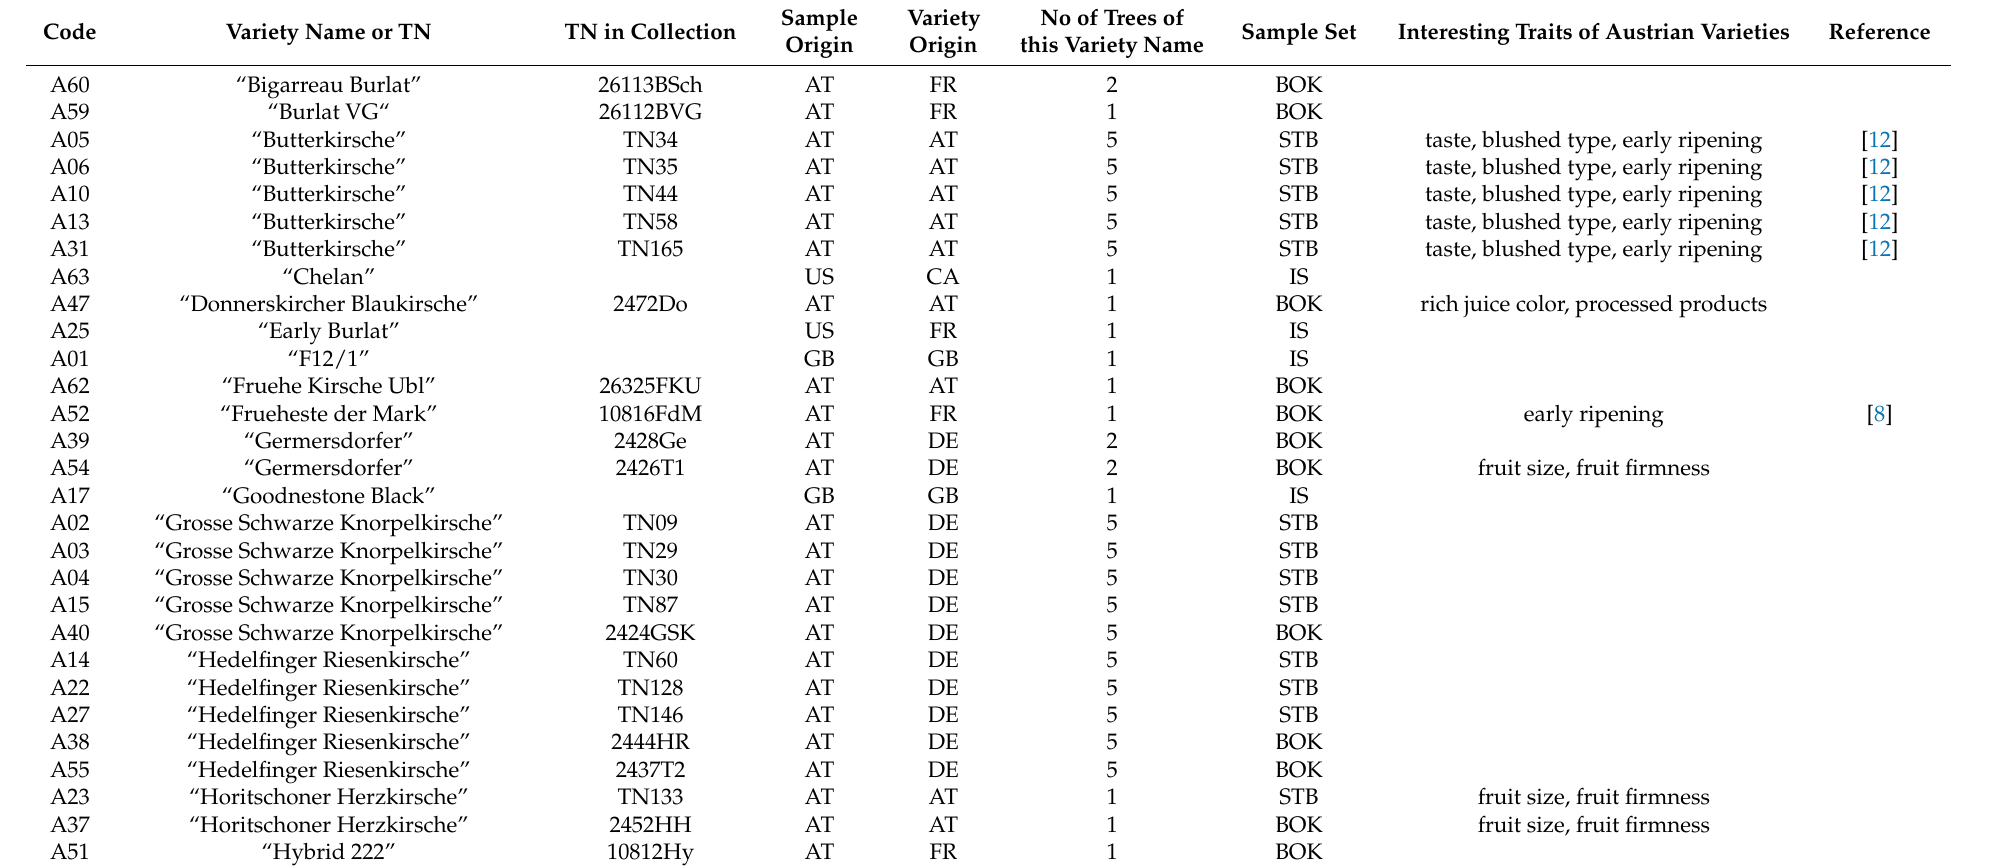
Table 1. List of accessions for simple sequence repeat (SSR) analysis, listed by their variety name or tree number (TN). Variety names in double quotes are internal working names for unidentified varieties in the germplasm collection. Code: Identifies the individual sample in the study; TN in Collection: Identifies the specific tree in the respective collection; Sample Origin: Country-Code where the plant material was collected; Variety Origin: Country-Code of the Country where this variety originated; Sample Set: Accessions belong to one of three sample sets: STB: Stoob, BOK: BOKU, Vienna germplasm collection, IS: International Standards; Interesting traits of Austrian varieties: Some traits of Austrian landraces are listed, that could be interesting for breeders are